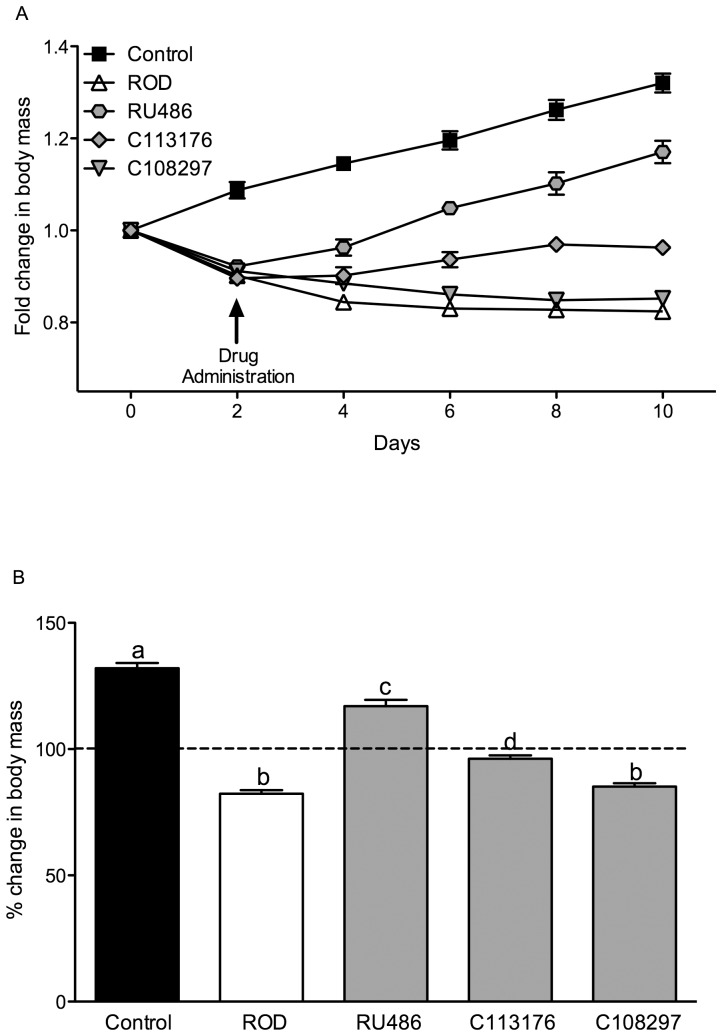
C113176 treatment maintains body mass while RU486 increases body mass with ROD treatment.Animal body mass (g) were recorded every two days for 10 days as a measure of fold change from day 0, pellet surgery (A). Animal body mass on day 10 was measured as a percent change of body mass from day 0 (B). The dotted line (100%) represents no change in body mass from day 0. Arrow indicates that 2 days after pellet surgeries respective antagonists or vehicle were administered at 80 mg/kg/day to each treatment group. Bars that do not share similar letters denote statistical significance, p<0.05, one-way ANOVA using Tukey's post-hoc test. n = 7–10. All values are means ± SE.